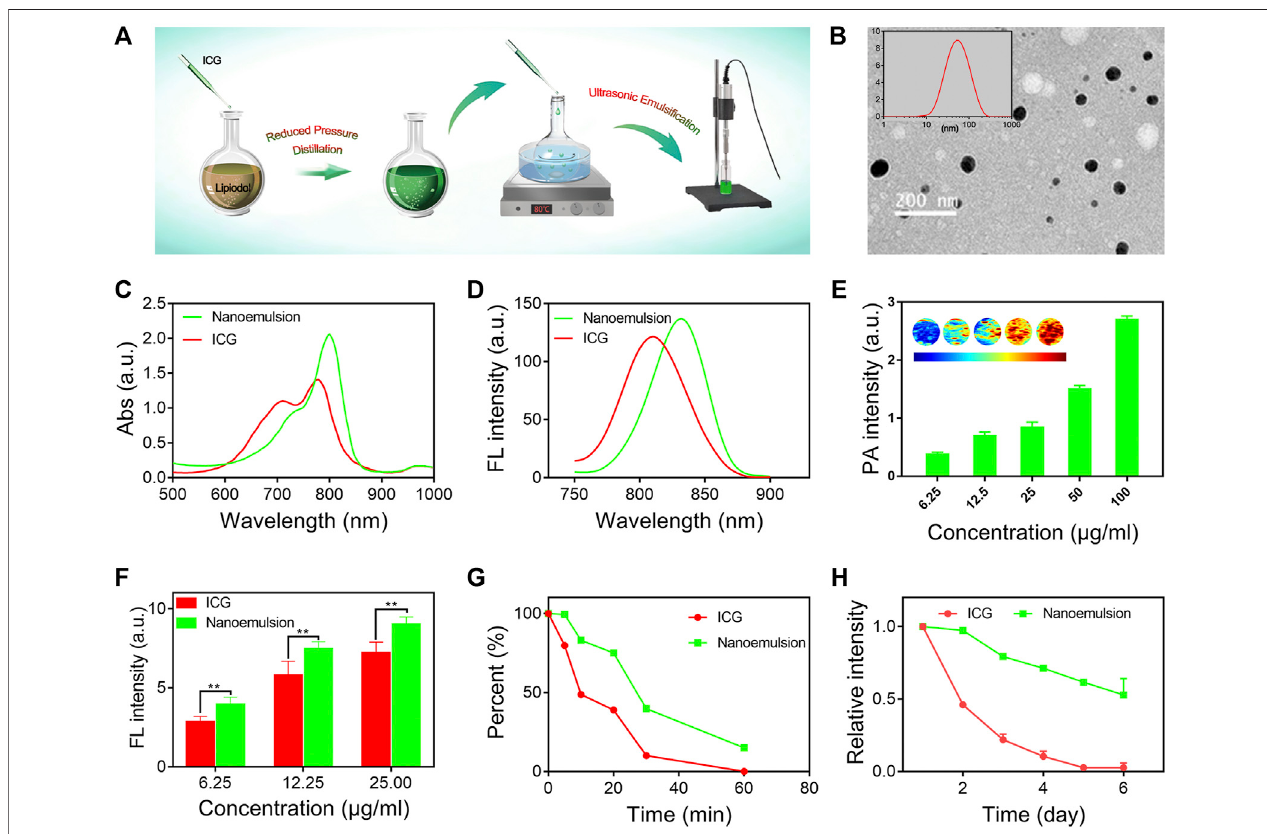
FIGURE 1 | (A) Schematic illustration of the preparation process of nanoemulsion. (B) TEM image and size distribution of nanoemulsion. (C) NIR-UV − vis spectra and (D) FL spectra of free ICG solution and nanoemulsion. (E) PA imaging signals of nanoemulsion with different ICG concentrations. (F) FL intensity comparison of free ICG solution and nanoemulsion at different concentrations. (G) FL intensity change of ICG and nanoemulsion after laser (2 W/cm 2 , 808 nm) irradiation. (H) FL intensity change of ICG and nanoemulsion after different storage